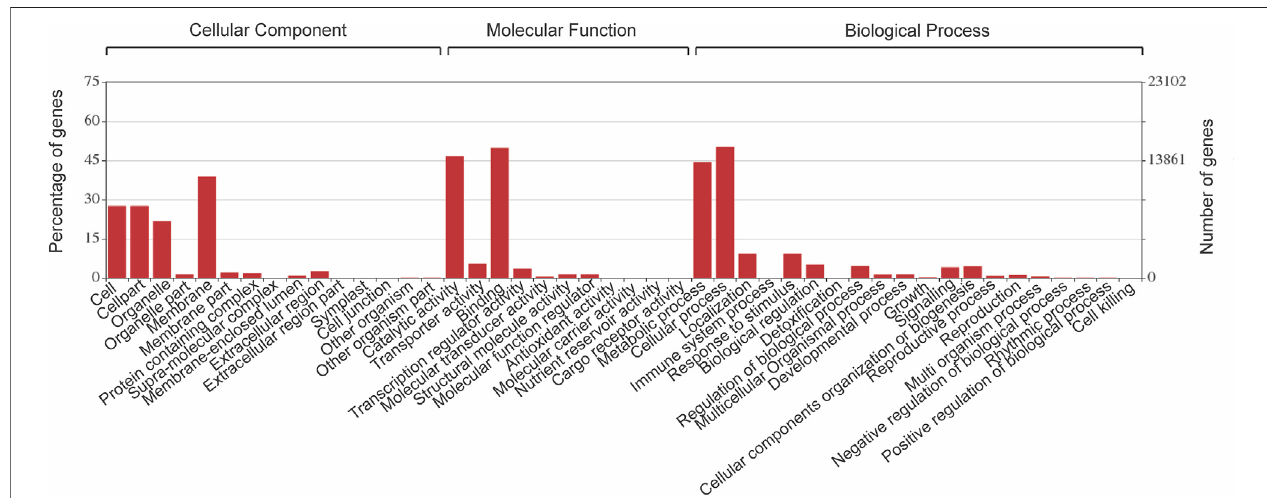
FIGURE 3 | Bar chart exhibits gene annotations of the functional classes in each of the three major categories, biological process (BP), cellular component (CC), and molecular function (MF), of gene ontology classi fi